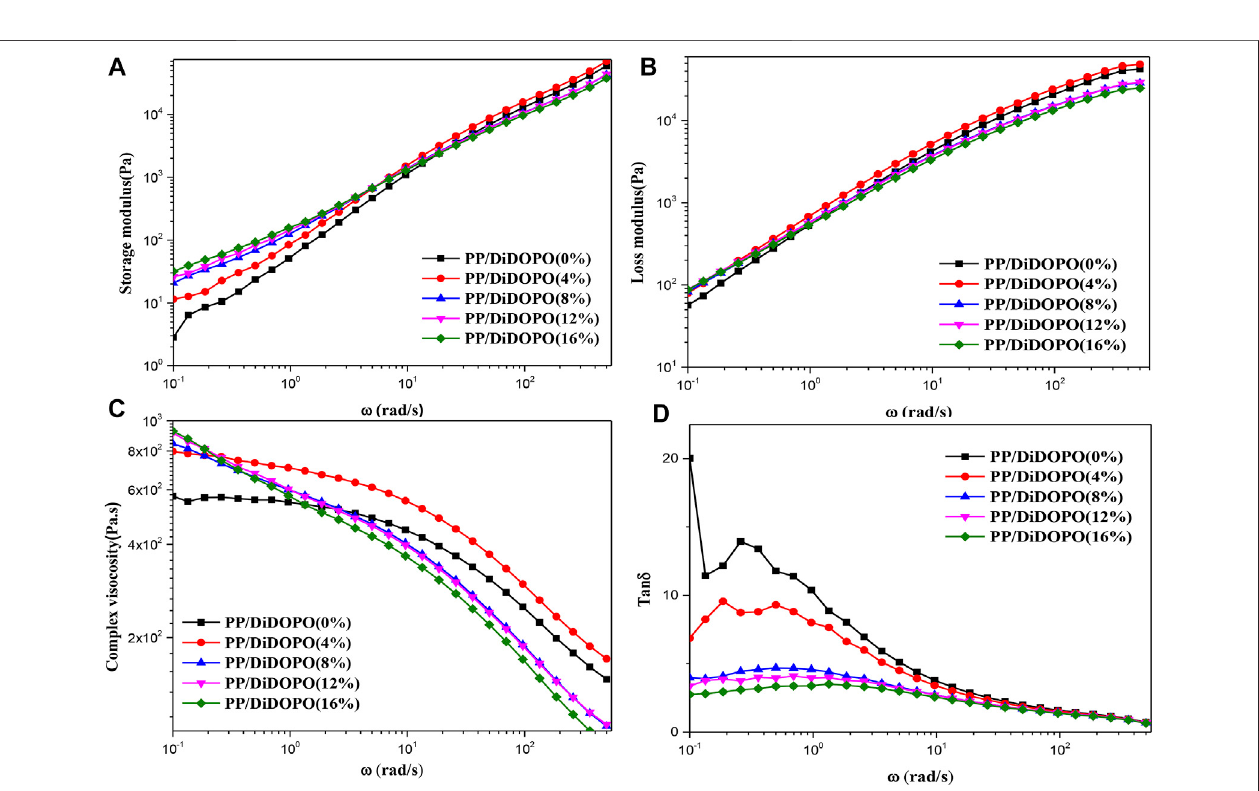
FIGURE 2 | Storage modulus (G ′ ) (A) , Loss modulus (G ″ ) (B) , Complex viscosity ( η *) (C) and Tan δ (D) for the PP/DiDOPO conjugated fl ame retardant composites at 190 ° C.